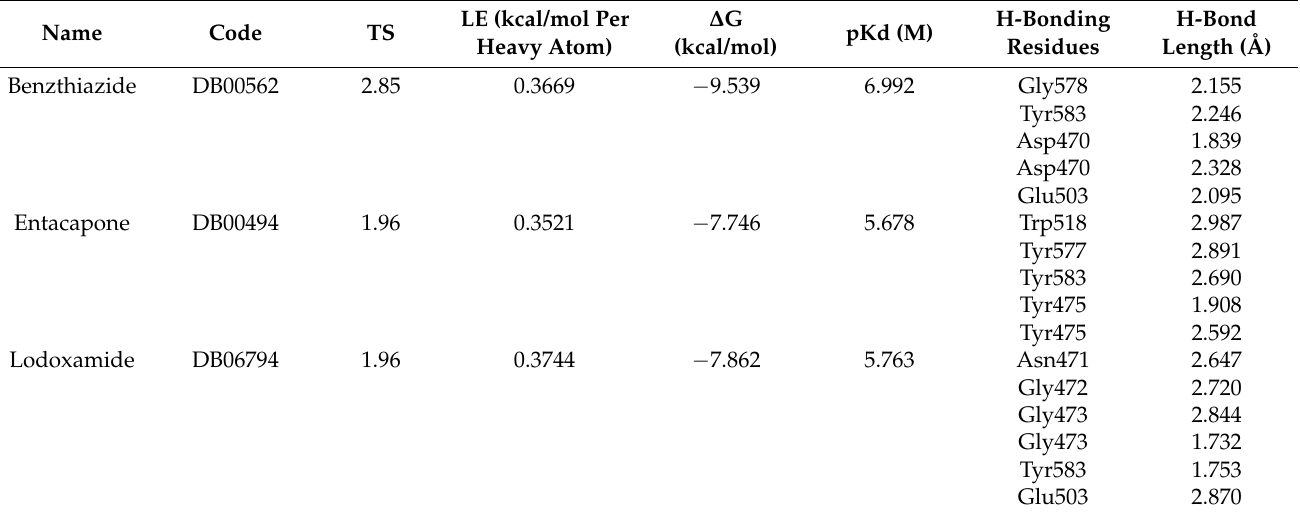
Table 7. Molecular docking simulations results and TS performance score for the best repurpos- ing